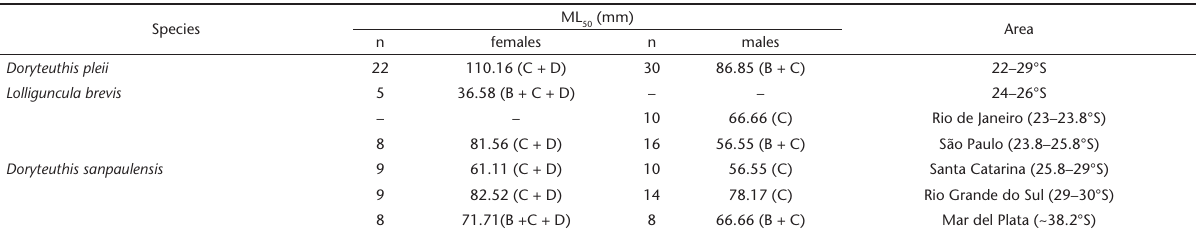
Figure 10. Size structure of Lolliguncula brevis caught off southern Brazil (24–26°S). Table 3. Size-at-maturity (ML ) of the three loliginid squids. Capital letters within brackets indicates the maturity stages used in the 50 calculations (see Table 1). n = sample